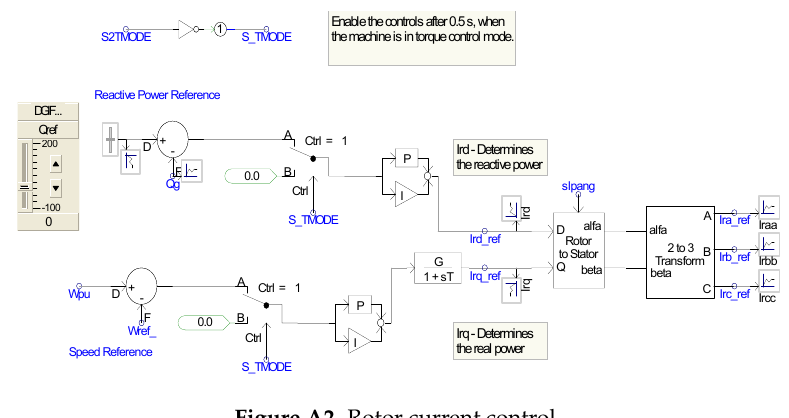
Figure A2. Rotor current control.